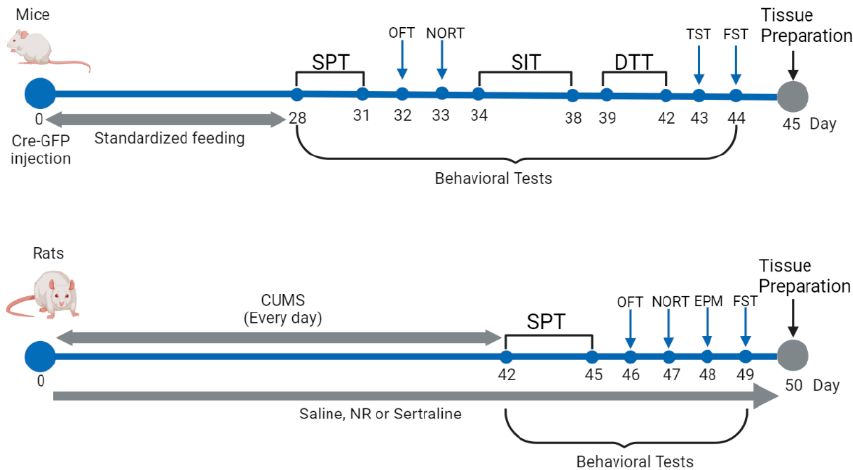
Figure 1. Schedules of the experimental protocol.